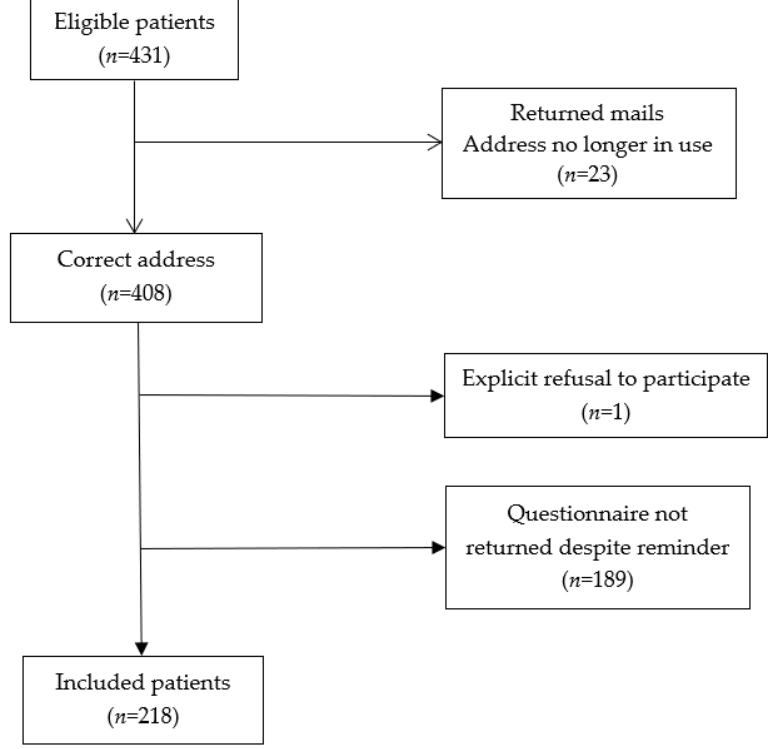
Figure 1. Study population flow-chart.